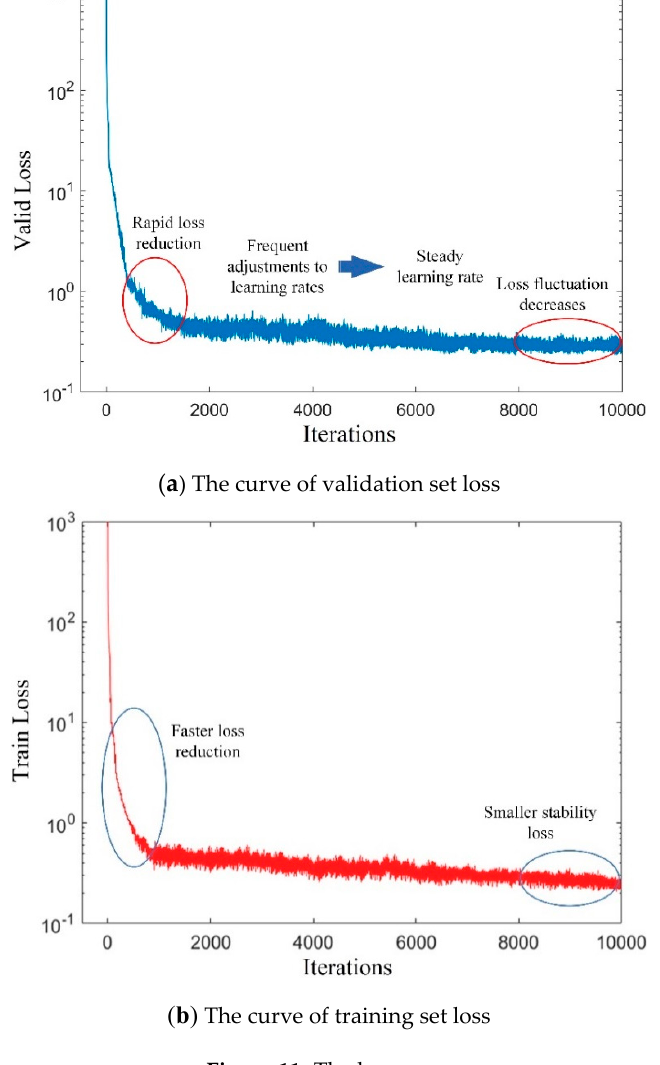
Figure 11. The loss curve.